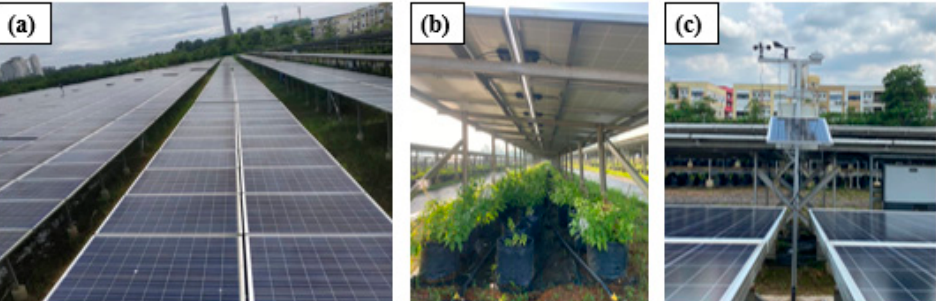
Figure 6. ( a ) LSS PV farm setup facing south with 5° slanting angle; ( b ) Misai Kucing plants were planted beneath the PV panels as agrivoltaic setup; ( c ) the weather station for LSS PV farm.